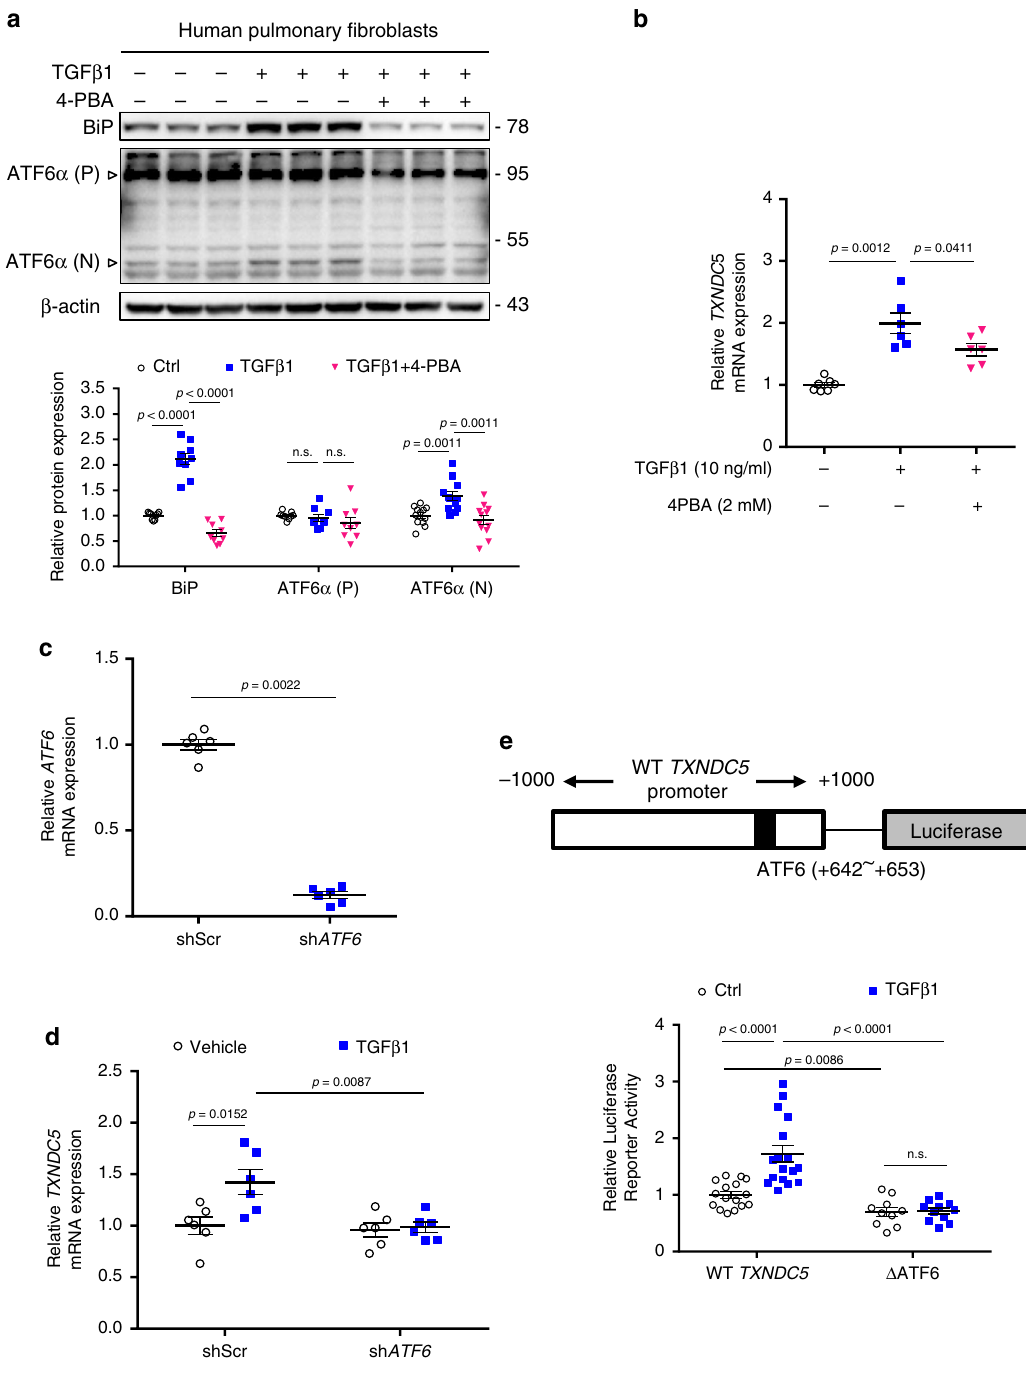
Fig. 9 TGF β 1 induces TXNDC5 expression in HPF through ER stress-dependent ATF6 activation. a TGF β 1 treatment in HPF led to increased ER stress levels, as re fl ected in upregulated ER stress markers BiP and ATF6 α (N) (activated ATF6). Co-treatment with 4-PBA (2 mM), an ER stress inhibitor, reversed TGF β 1-induced increases in BiP and ATF6 α (N) (Bip, ATF6 α (P): n = 9 biologically independent samples per group, ATF6 α (N): n = 12 biologically independent samples per group). b TXNDC5 mRNA was increased in response to TGF β 1 treatment, which was signi fi cantly attenuated by 4-PBA ( n = 7,6,6 biologically independent samples). c Knockdown ef fi ciency of lentiviral vectors carrying ATF6 -targeted shRNA in HPF (n = 6 biologically